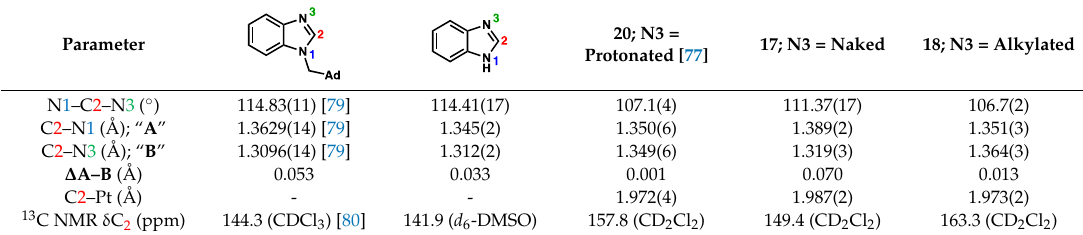
Table 1. Comparisons of fundamental structural and spectroscopic data for NH,NR ( 20 ), N,NR, ( 17 ), and NR,NR NHC ( 18 ) complexes relative to reference benzimidazoles.